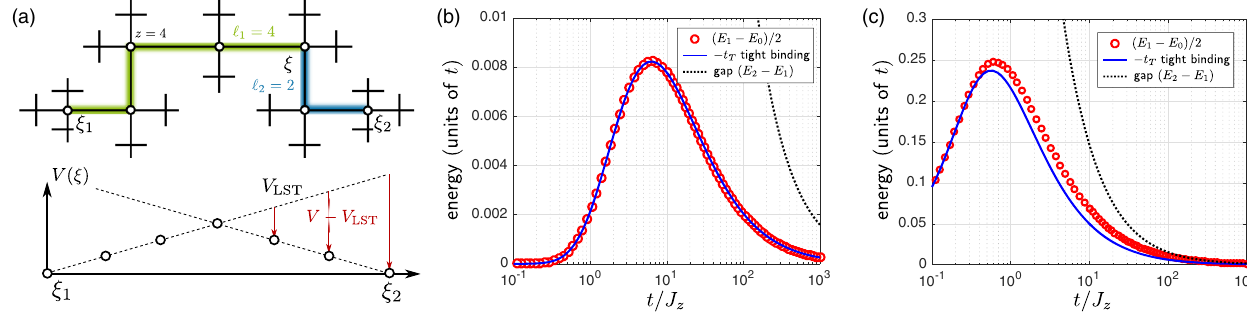
FIG. 26. Toy model for Trugman loop tunneling. (a) We consider a single particle hopping between the sites ξ of a Bethe lattice with coordination number z . The potential energy V ð ξ Þ ¼ J min ð l 1 ; l 2 Þ is determined by the smaller of the two distances to the two spinon z sites ξ 1 and ξ 2 . The distance l between ξ 1 and ξ 2 corresponds the length of the Trugman loop. In (b) and (c) we compare the energy T splitting ð E 1 − E 0 Þ /2 of the lowest two eigenstates of the toy model to the tight-binding Trugman loop hopping element t and the T 6 in (b) and z ¼ 3 and l 2 in energy gap Δ ¼ E 2 − E 1 to higher excited states. Parameters are z ¼ 4 and l T ¼ T ¼